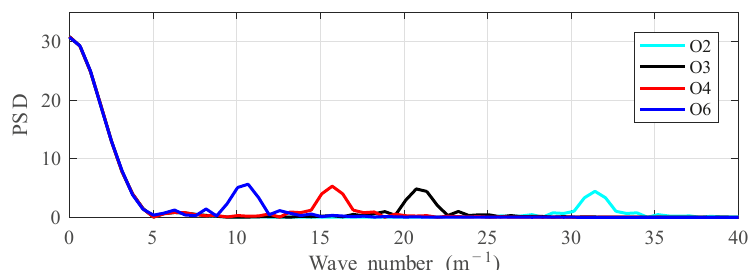
Figure 12. Power spectral density (PSD) of the initial horizontal velocity fields, computed from some of the overtaking collision